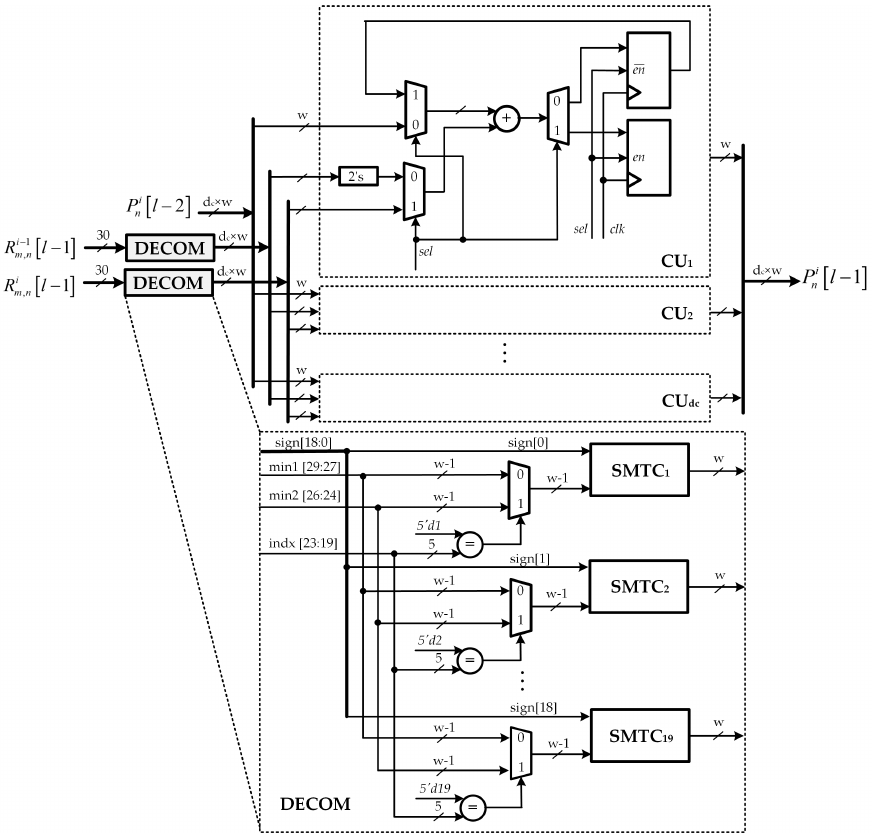
Figure 9. Proposed a posteriori information update unit